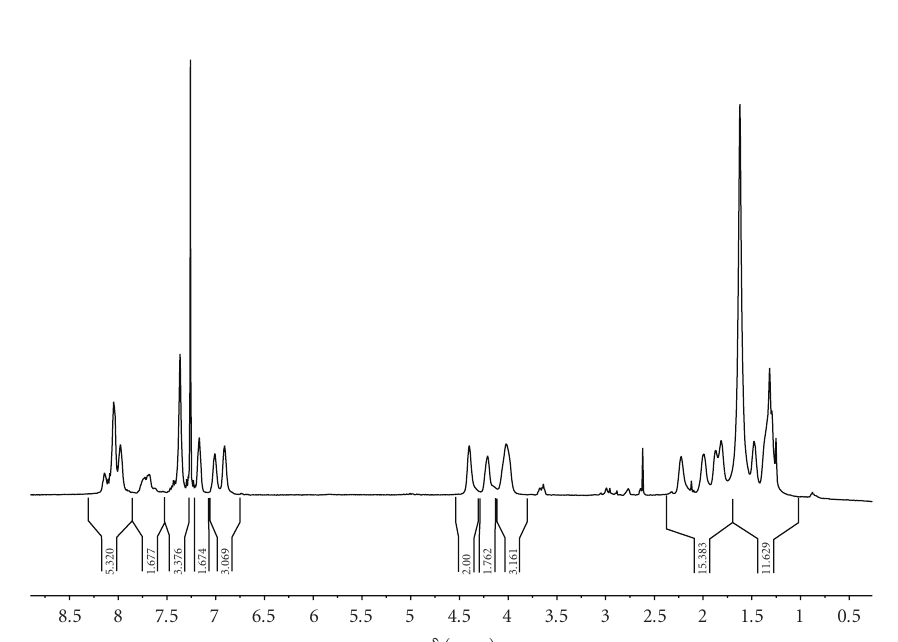
Scheme 3: Synthesis of the polymers (POC).